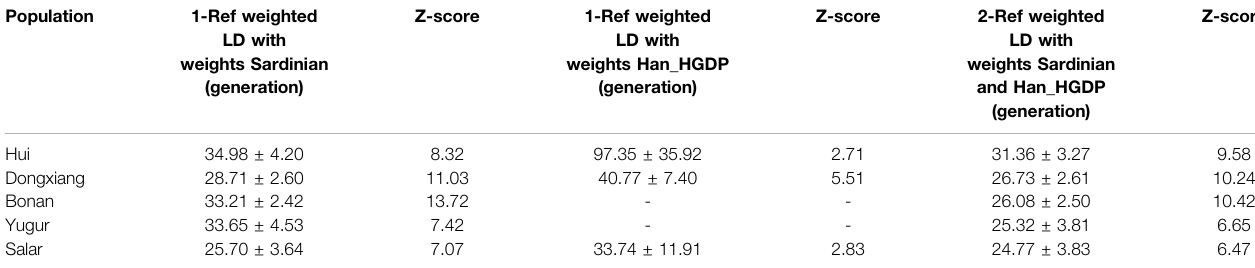
TABLE 5 | The admixture time estimation by ALDER for our studied populations. Population 1-Ref weighted LD with